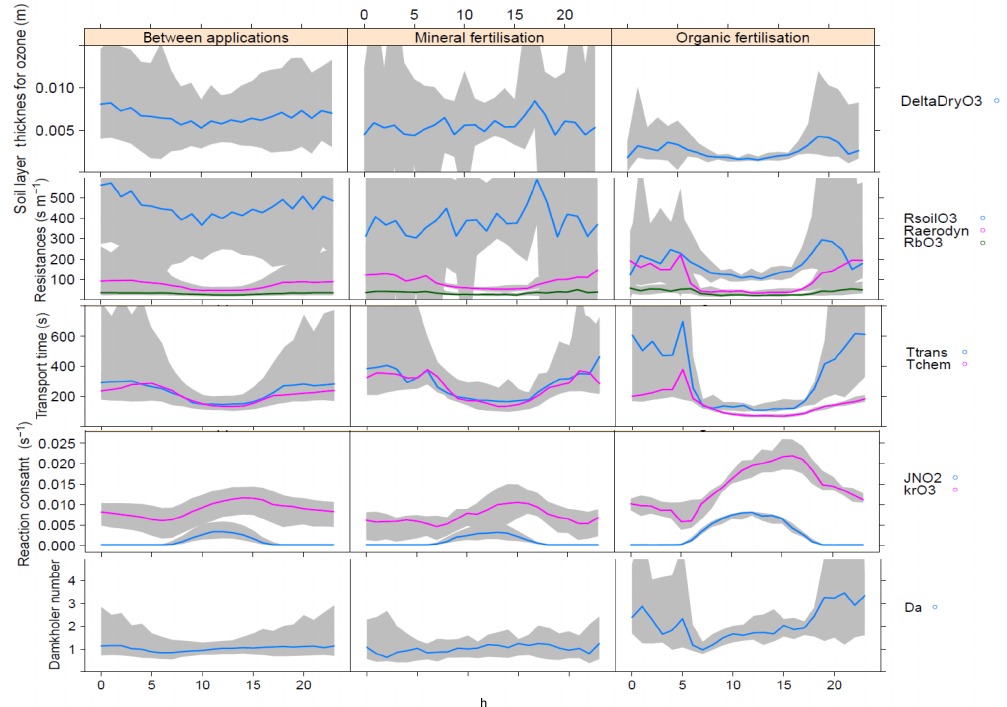
Figure 9. Diurnal cycles of the O 3 penetration depth in the soil ( (cid:49) dryO resistances ( R soilO ) for O 3 , the chemical reaction time τ chem and transport time τ trans , the chemical reaction rates for NO 2 photolysis J NO 3 and NO depletion by O 3 ( k r ×[ O 3 ] ), and the Damköhler number ( Da ), averaged over the periods of interest at the Grignon field site. The shaded areas represent the interquartile